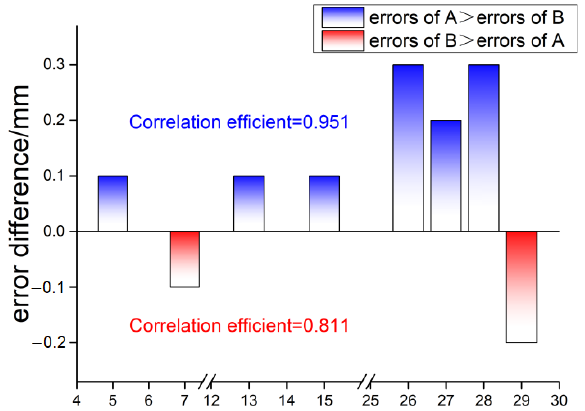
Figure 15. SVM prediction error differences between A and B.